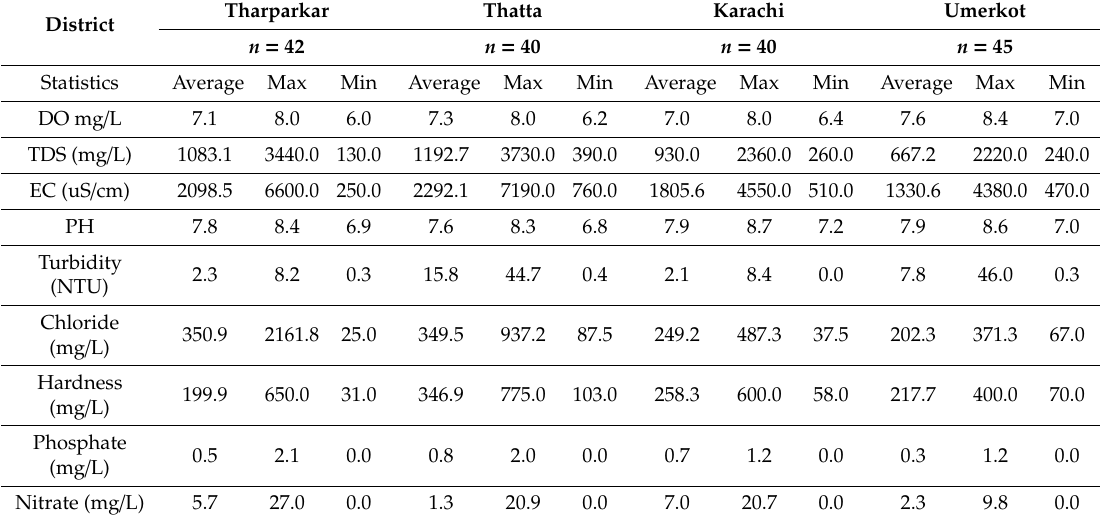
Table 4. Water quality parameters of South Sindh.